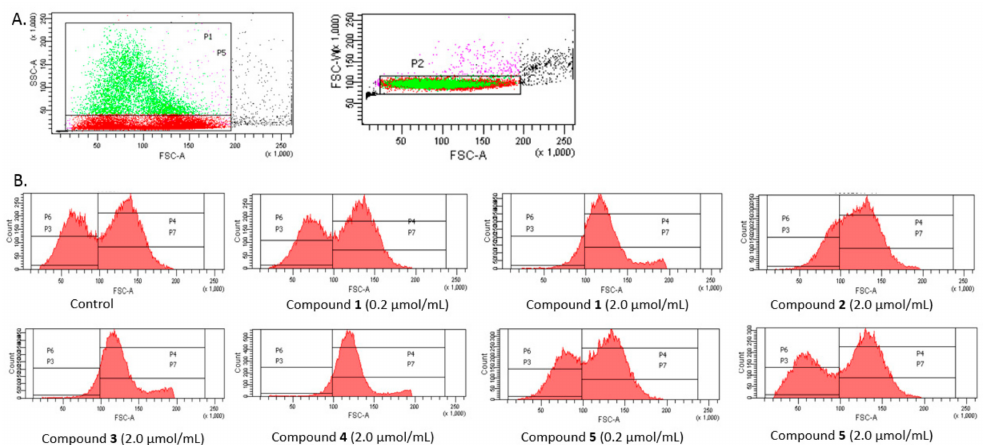
Figure 9. Effects of iminodiacetic acid derivatives on erythrocytes (flow cytometry studies). ( A ) On the basis of SSC-A (side scattered light A) parameter, subpopulation of erythrocytes marked in